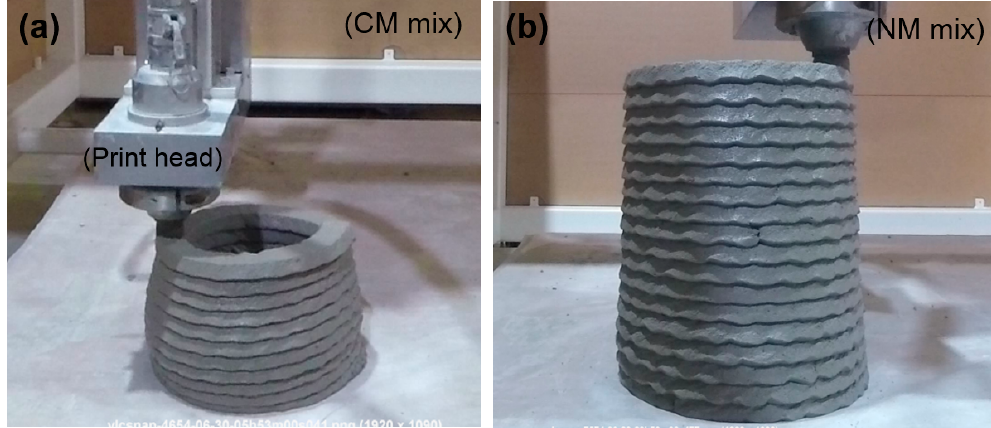
Figure 4. Demonstration of 3D printability of ( a ) control mix (CM); ( b ) 0.5% clay modified NM mixture.